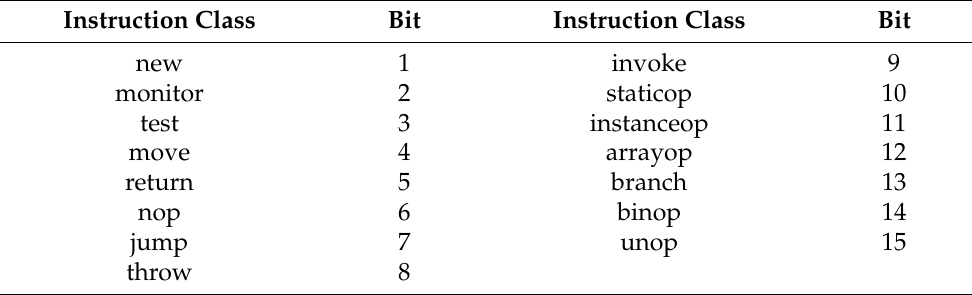
Table 3. Instruction class and corresponding bit representation.